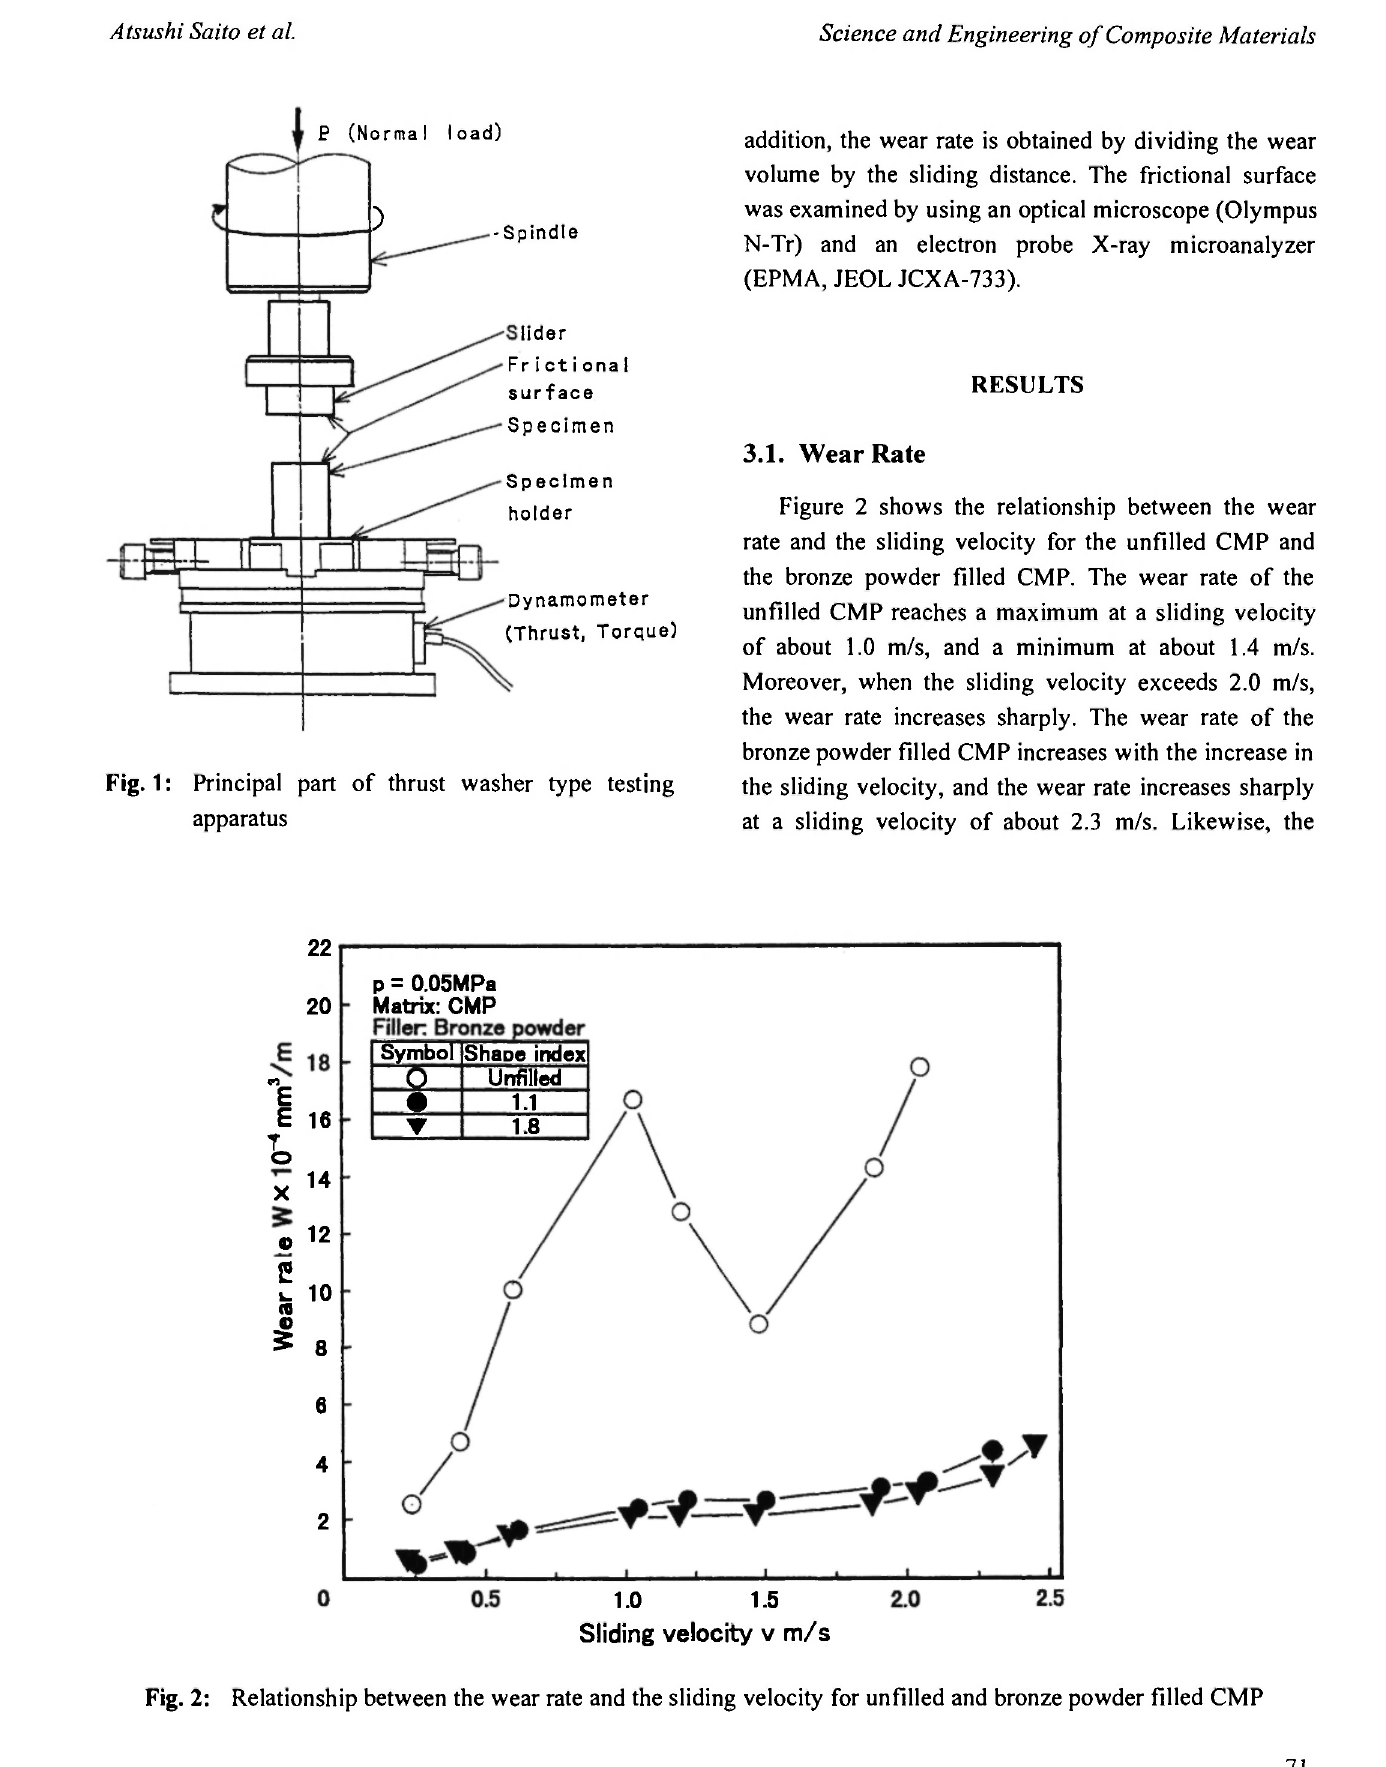
Fig. 1: Principal part of thrust washer type testing apparatus